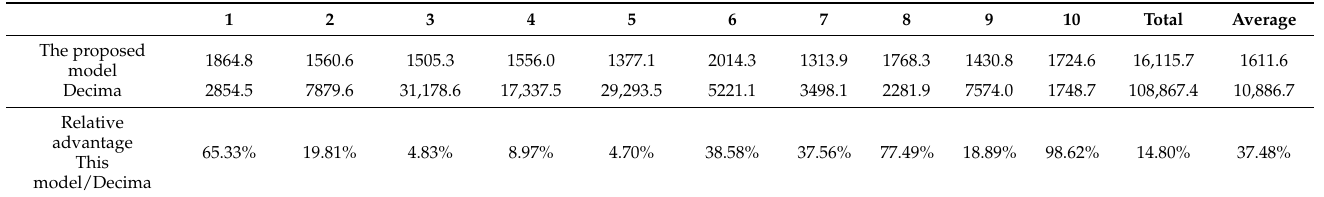
Table 3. JCT(s) on the mixed dataset.